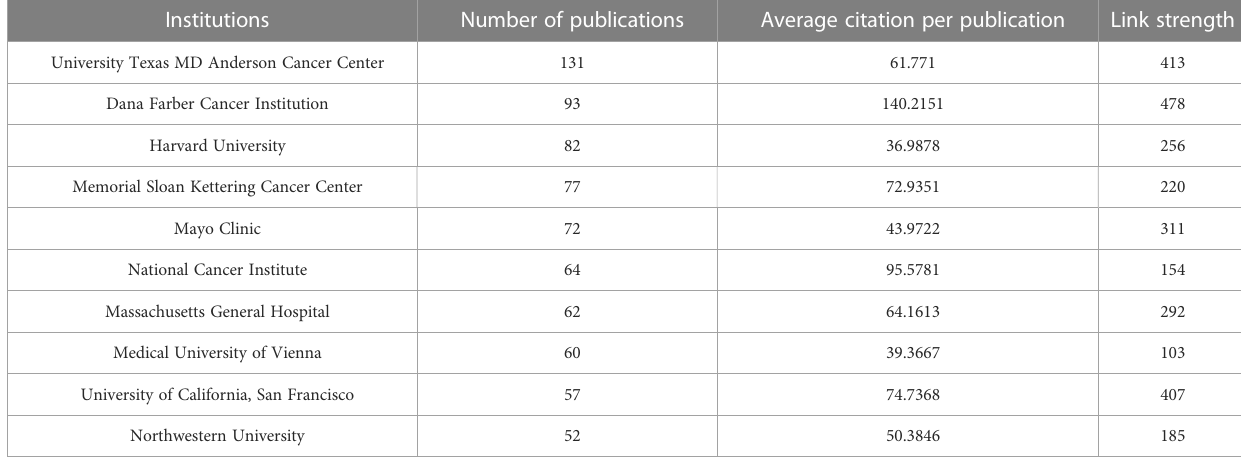
TABLE 2 10 most productive and cited institutions.